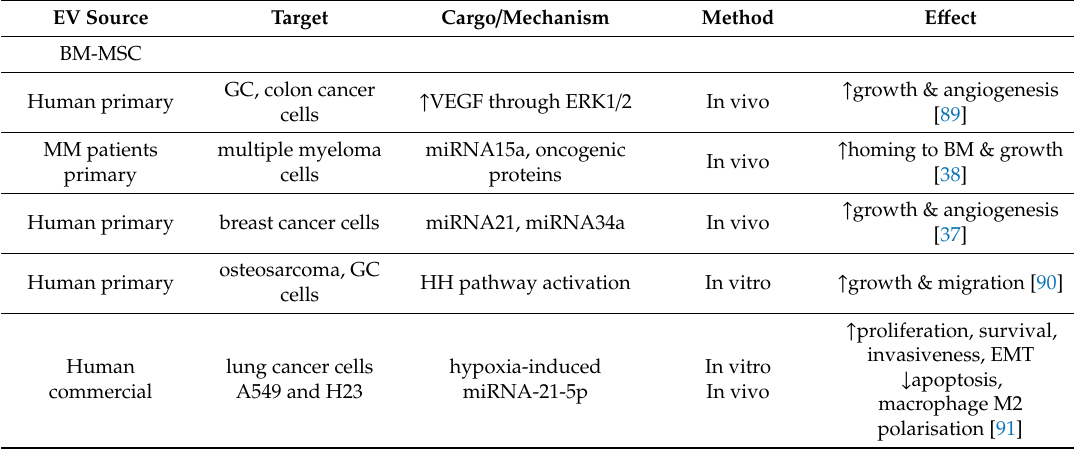
Table 1. Summary of pro-cancer e ff ects of